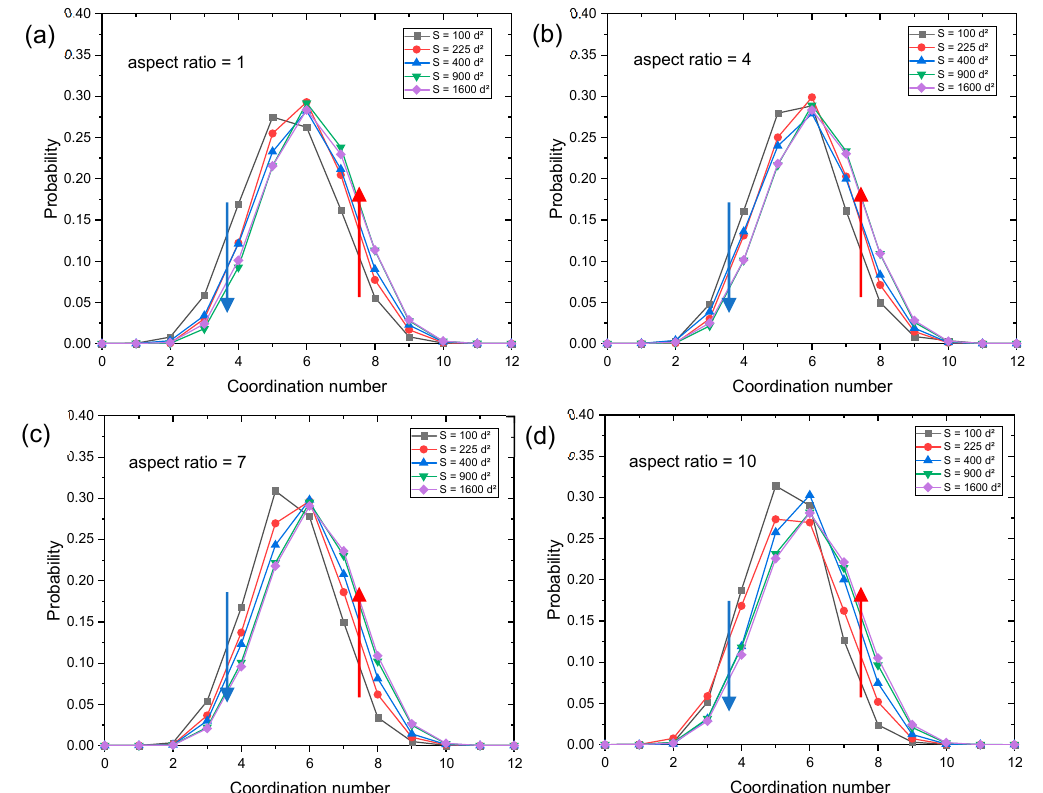
Figure 16. Effect of the cross-sectional area on the coordination number distribution of the rectangular pebble beds: ( a ) aspect ratio = 1, ( b ) aspect ratio = 4, ( c ) aspect ratio = 7, ( d ) aspect ratio = 10.